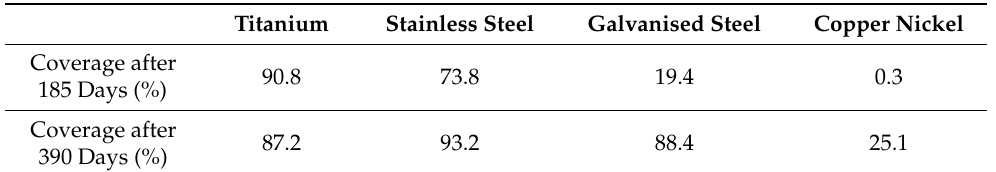
Table 3. Biofouling observations on metals sheets immersed in 3 m of seawater for 185 and 390 days, Ennore Port [64].